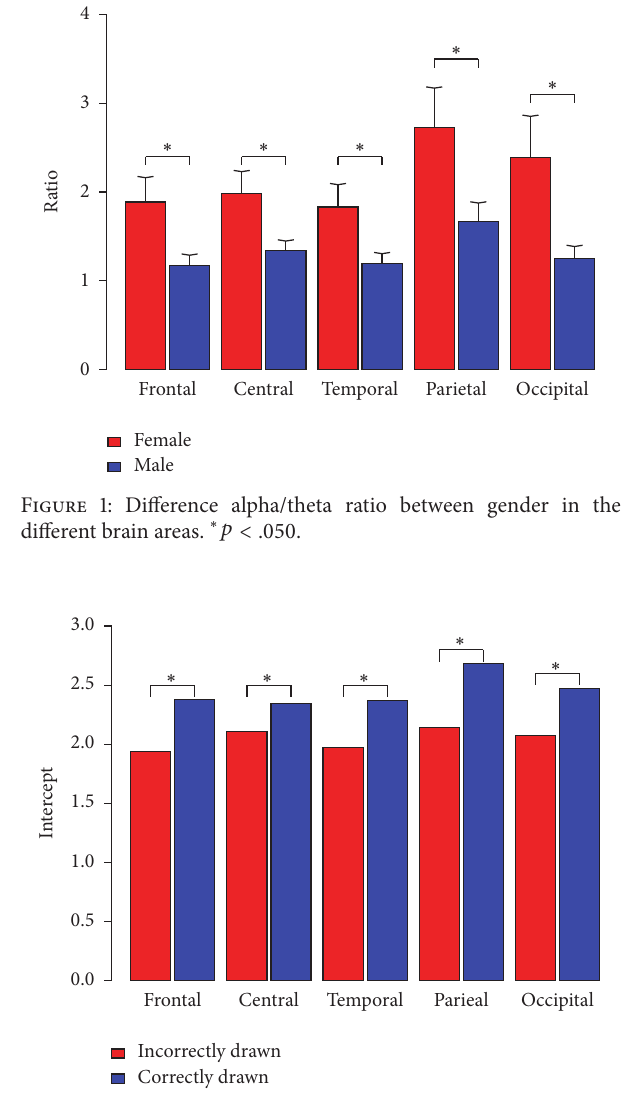
Figure 2: Comparison intercept between incorrectly and correctly drawn Clock Drawing Test groups related to the alpha/theta ratio in the different brain areas. ∗ 𝑝 < .050